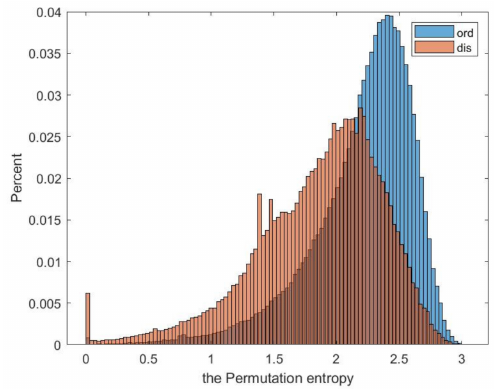
Figure 3. Probability distribution